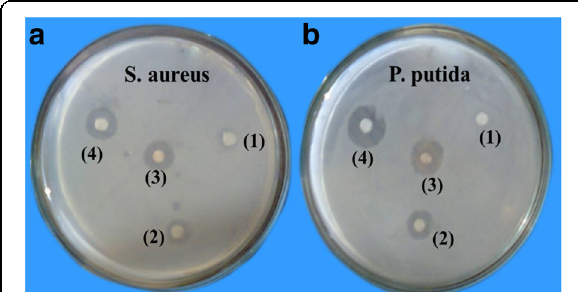
Fig. 14 Antibacterial activity of papaya leaf extract capped AuNPs using ( a ) Staphylococcus aureus ( b ) Pseudomonas putida (1 mg/ml solution: discs containing 1 = 10 μ l of papaya leaf extract solution, 2 = 10 μ l of AuNPs, 3 = 20 μ l of AuNPs, 4 = 10 μ l of